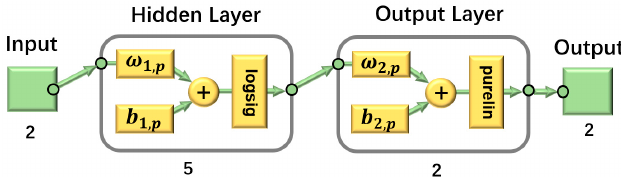
Figure 9. The BPNN for performance comparison with the SSM, where ω 1, p and ω 2, p are the weights, b 1, p and b 2, p are the bias values. Di ff erent from the BPNN for the measurement model of SSM, the input vector x k whose dimension is 2 contains the extracted EMG feature and the interactive force, and the output vector y k whose dimension is 2 contains the joint angle and angular velocity, and 2, 5 and 2 are the numbers of the